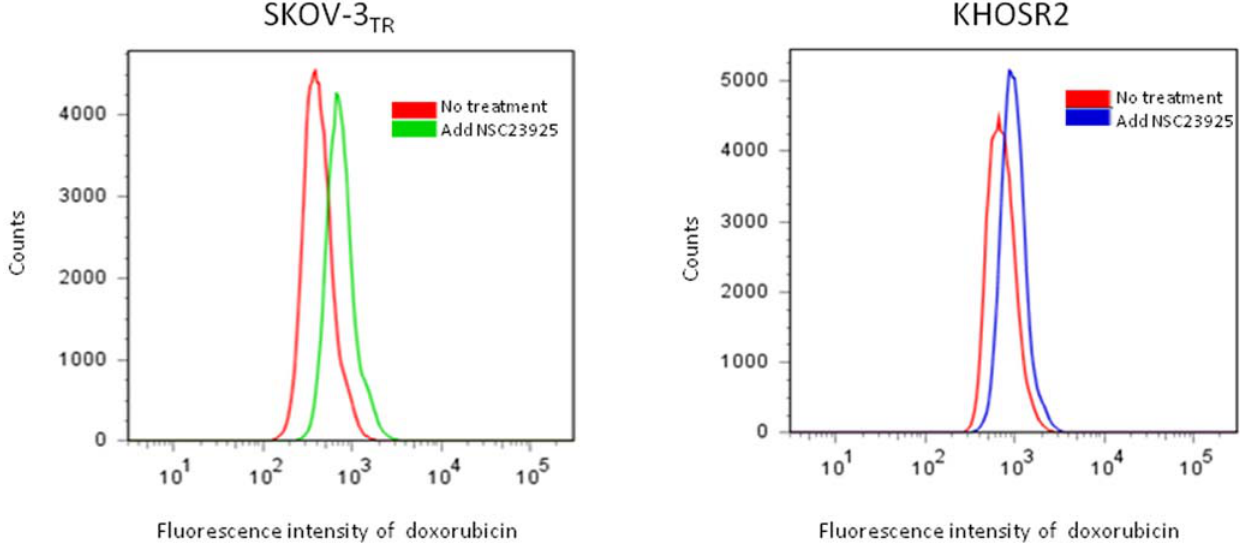
Figure 8. Intracellular retention of doxorubicin from multidrug resistant SKOV-3 TR and KHOSR2 cells in the presence of 5 m M doxorubicin with or without treatment of NSC23925 (0.5 m M). Cells were treated for 1 hour before the flow cytometry